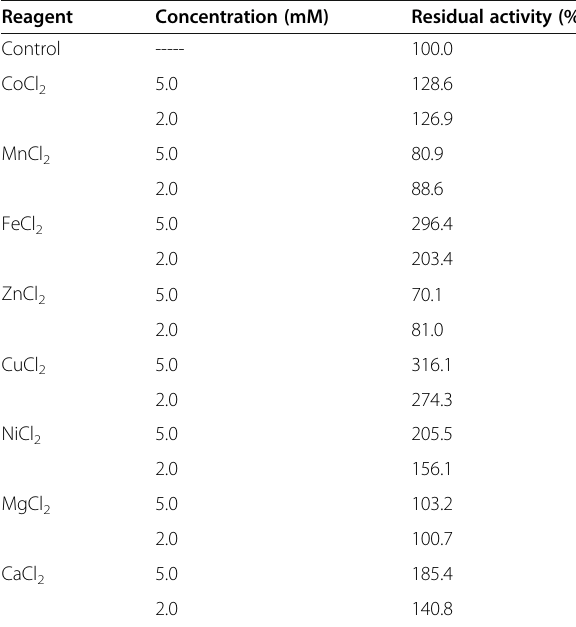
Table 2 Effect of divalent cations on Egyptian honey bee venom PLA2